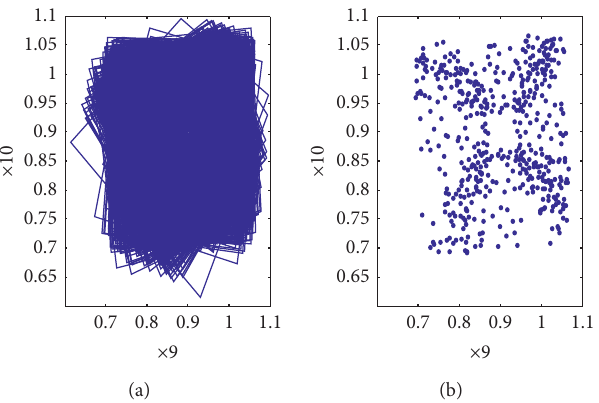
with random perturbation, 10